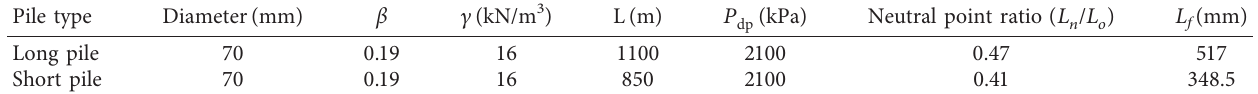
Table 2: Neutral point L f of the long and short piles.